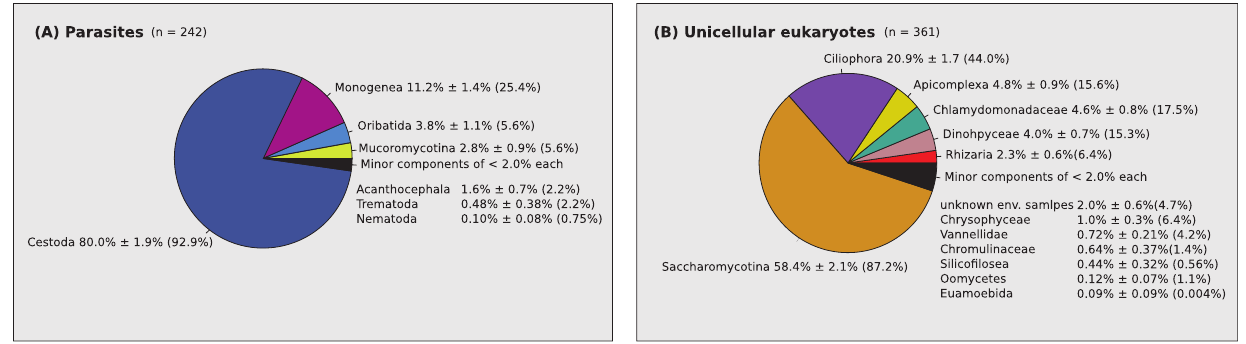
Figure 5. Parasites and unicellular eukaryotes in Ade´lie penguin scats. Sequences classified as parasites (A) and unicellular eukaryotes (B) identified in all penguin scats analysed in this study. The pie charts show the estimated mean and standard error of the proportions of each sequence type with the percentage FOC in brackets.